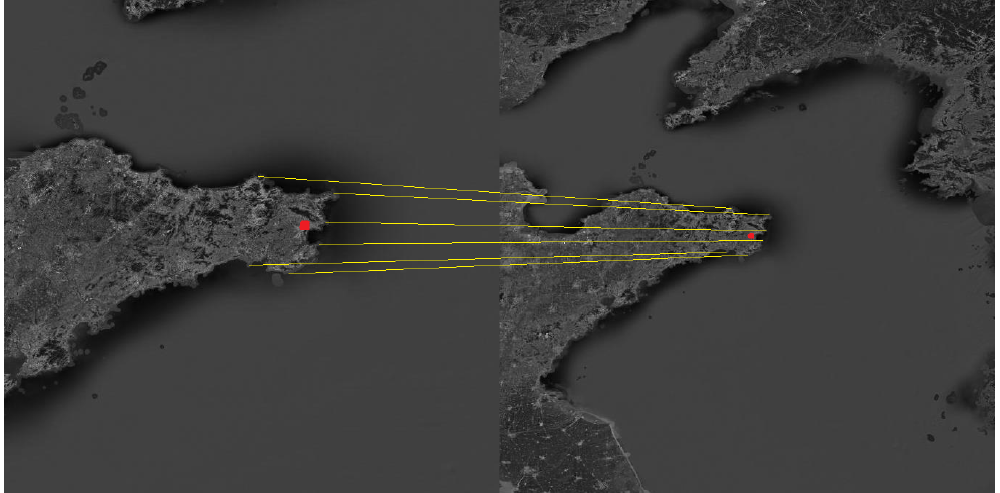
Figure 5. Schematic diagram of the matching process about the Shandong Peninsula.